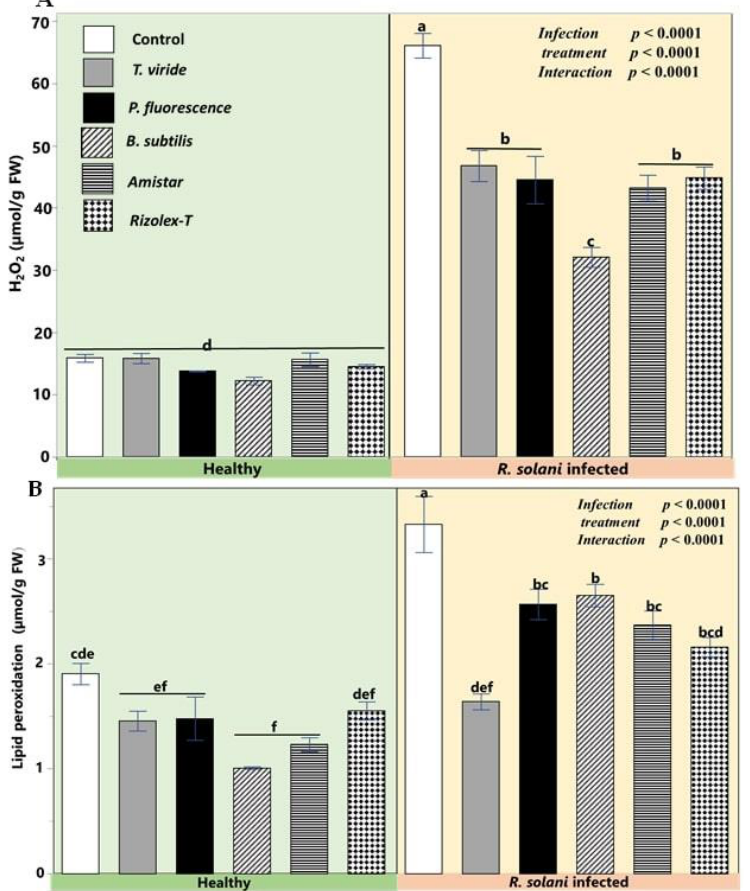
Figure 7. Effects of biocontrol agents on oxidative stress compounds in coriander infected by R. solani. ( A ) Hydrogen peroxide ( µ mol g − 1 FW), and ( B ) lipid peroxidation ( µ mol g − 1 FW). Data presented are the means ± the standard deviation (mean ± SD) of five biological replicates. Different letters indicate statistically significant differences among treatments, while the same letters signify no significant differences between them according to a Tukey’s honestly significant difference test ( p < 0.05).